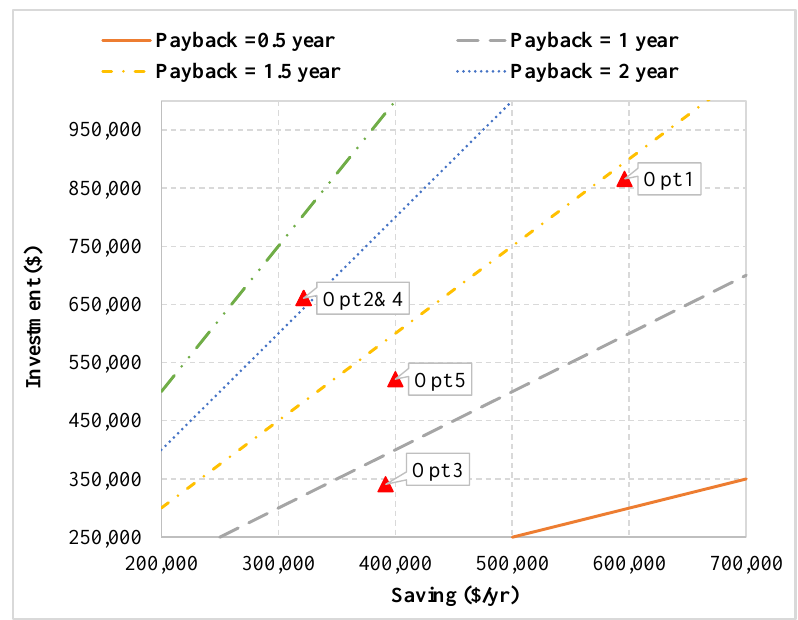
Figure 9. Investment, saving, and payback at optimum HRAT for retrofit options.